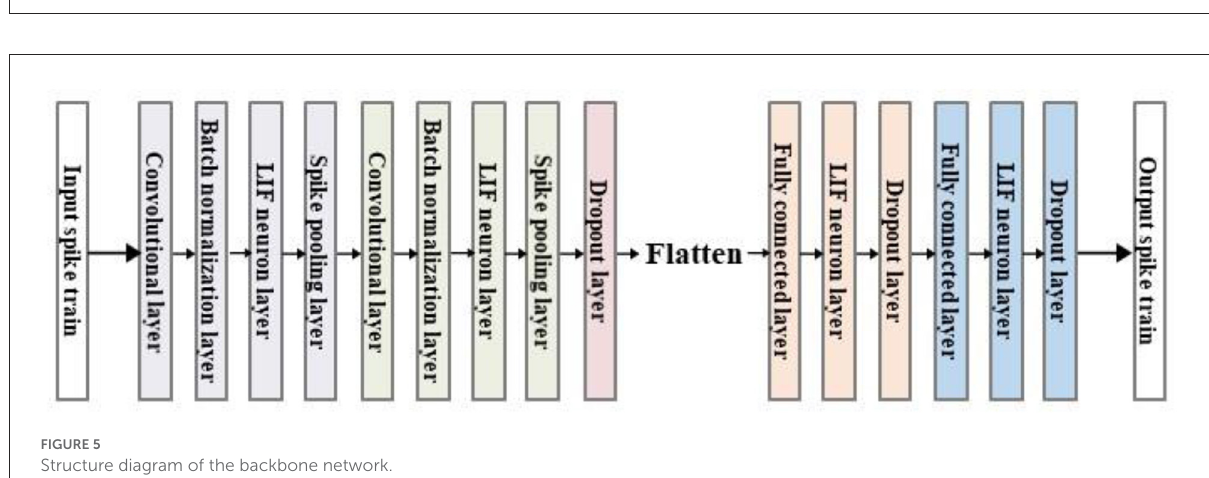
FIGURE4 Schematic diagram of the spike max pooling. (A,B) In each time step, only the most active neurons in the pooling window can communicate with the neurons in the next layer. (C,D) When two or more neurons fire the spikes at the same time, one of the neurons is randomly selected for the messaging.